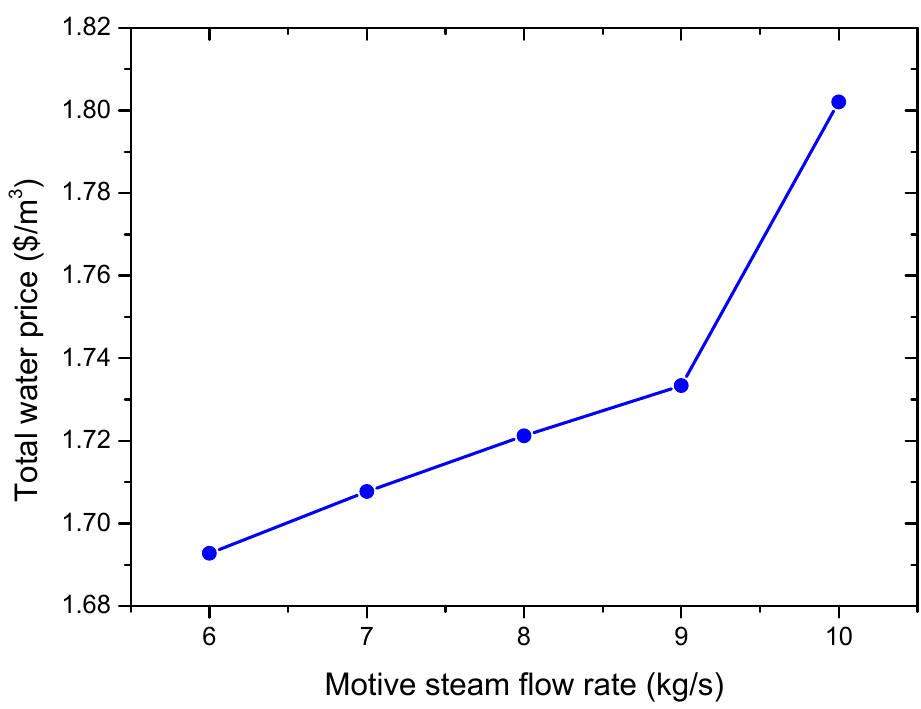
Figure 6. Effect of motive steam flow rate on the TWP.